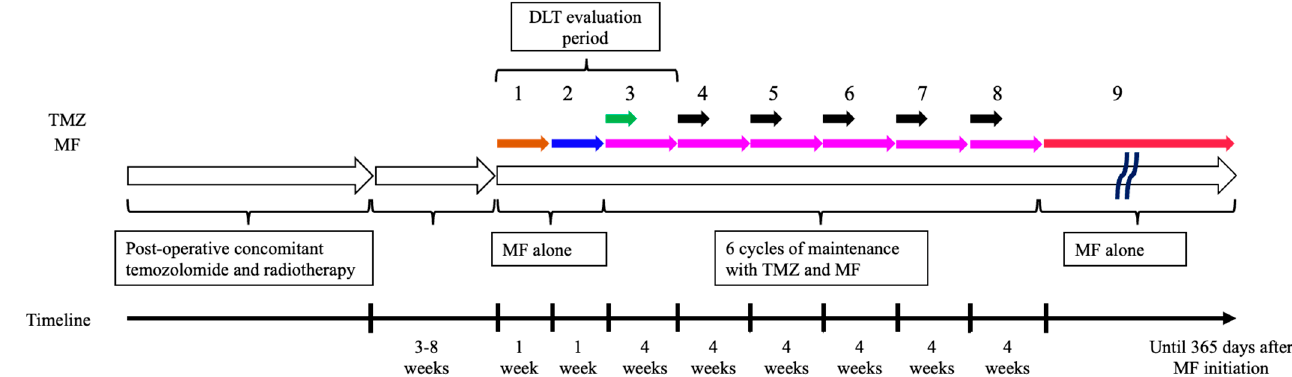
Figure 1. Treatment schedule. Treatment with metformin (MF) Step 1 dose was to be initiated within 3 to 8 weeks from the last day of concomitant temozolomide (TMZ) and radiotherapy. Dose-limiting toxicity (DLT) was evaluated from the day of MF initiation to 28 days after the start of Cycle 1 involving (MF) and (TMZ). The numbers 1–9 indicate the following: 1. MF alone with Step 1 dose for 7 days (Brown arrow); 2. MF alone with Step 2 dose for 7 days (Blue arrow); 3. Maintenance therapy Cycle 1: MF with Step 3 dose for 28 days (Pink arrow) and TMZ (150 mg/m 2 /day) for 5 days (Green arrow); 4. Maintenance therapy Cycle 2: MF with Step 3 dose for 28 days (Pink arrow) and TMZ (200 mg/m 2 /day) for 5 days (Black arrow); 5. Maintenance therapy Cycle 3: MF with Step 3 dose for 28 days (Pink arrow) and TMZ (200 mg/m 2 /day) for 5 days (Black arrow); 6. Maintenance therapy Cycle 4: MF with Step 3 dose for 28 days (Pink arrow) and TMZ (200 mg/m 2 /day) for 5 days (Black arrow); 7. Maintenance therapy Cycle 5: MF with Step 3 dose for 28 days (Pink arrow) and TMZ (200 mg/m 2 /day) for 5 days (Black arrow); 8. Maintenance therapy Cycle 6: MF with Step 3 dose for 28 days (Pink arrow) and TMZ (200 mg/m 2 /day) for 5 days (Black arrow); 9. MF alone with Step 3 dose until 365 days from MF initiation (Red arrow).